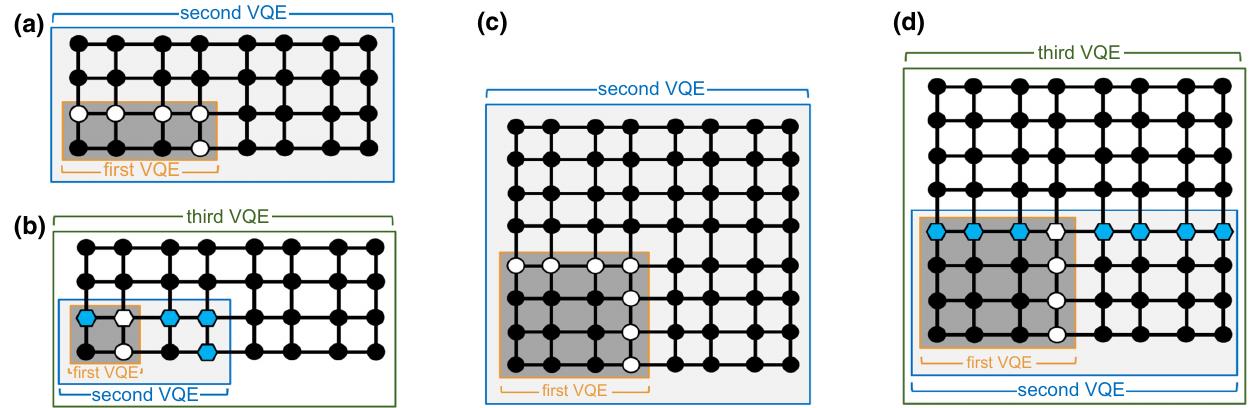
FIG. 4. The protocol of concatenating of VQEs employed in the numerical demonstration of 2D systems. Qubits marked by white symbols are located at the boundary of subsystems for the first VQE. Hexagons (both blue and white) indicate the boundary sites of subsystems for the second VQE, which are used for constructing the local basis following Eq. (31). (a) 32 sites with the concatenation up to the second VQE. (b) 32 sites with the concatenation up to the third VQE. (c) 64 sites with the concatenation up to the second VQE. (d) 64 sites with the concatenation up to the third